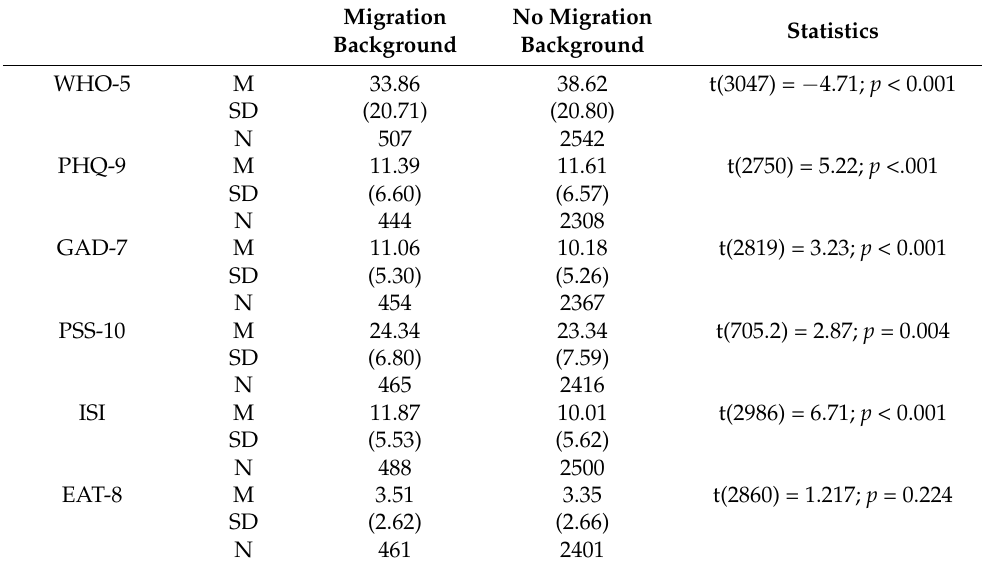
Table 5. Mean score of psychological health by migration background (whole sample, N =